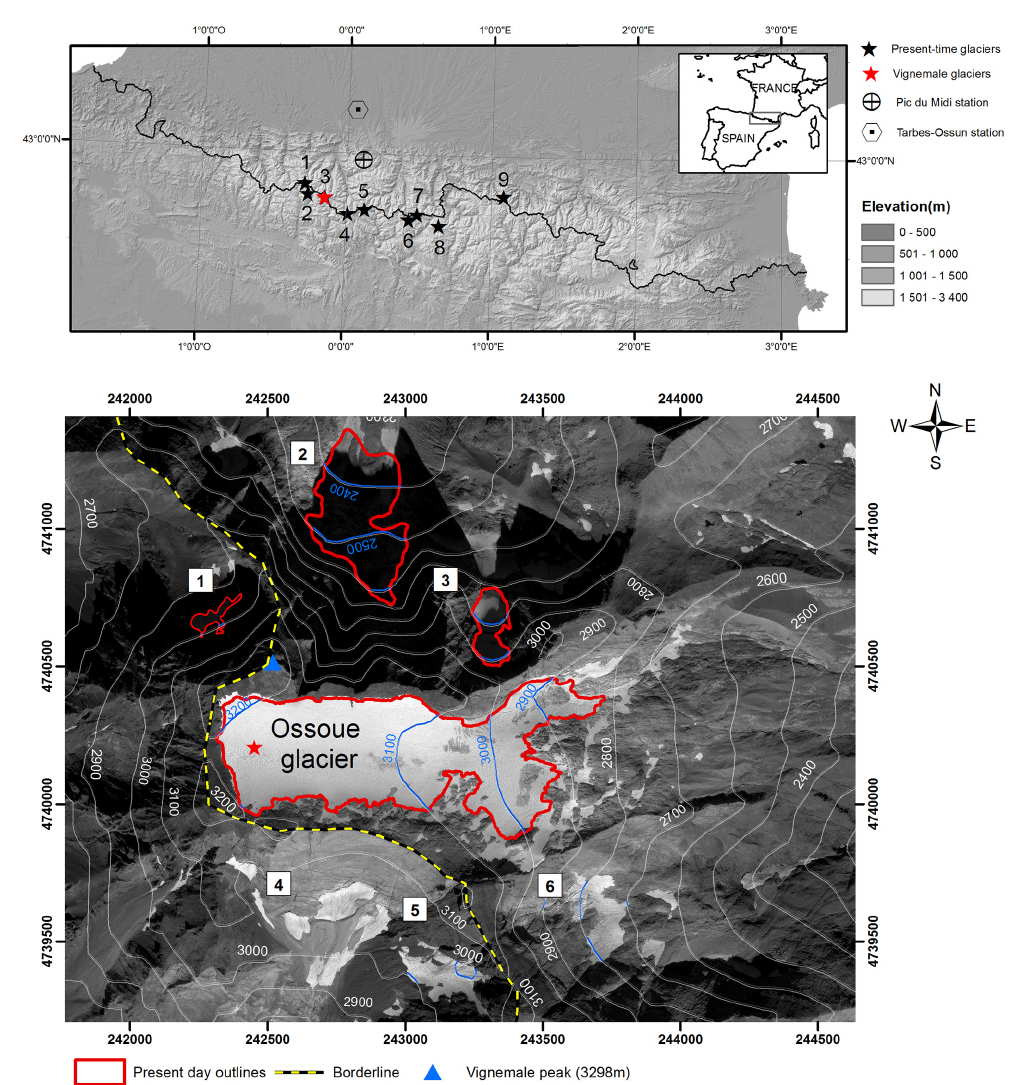
Figure 1. Top: distribution of the present-day Pyrenean glaciers by mountain massifs: 1. Balaïtous; 2. Infierno; 3. Vignemale; 4. Gavarnie Monte Perdido; 5. Munia; 6. Posets; 7. Perdiguère; 8. Aneto; 9. Mont Valier. Bottom: Vignemale Glacieret: 1. Clot de la Hount. Glaciers: 2. Oulettes de Gaube; 3. Petit Vignemale and Ossoue. Vanished glaciers: 4. Spanish Montferrat; 5. Tapou; 6. French Montferrat. We note that the vanished glaciers were oriented to the southwest and east. Clot de la Hount is northwest-oriented and its area is less than 0.01km 2 (2011). North-oriented glaciers Oulettes de Gaube, 0.13km 2 (2011), and Petit Vignemale, 0.03km 2 (2011), were one unique glacier until 1888 (Reid-Muret, 1906). Coordinate system: UTM 31 ◦